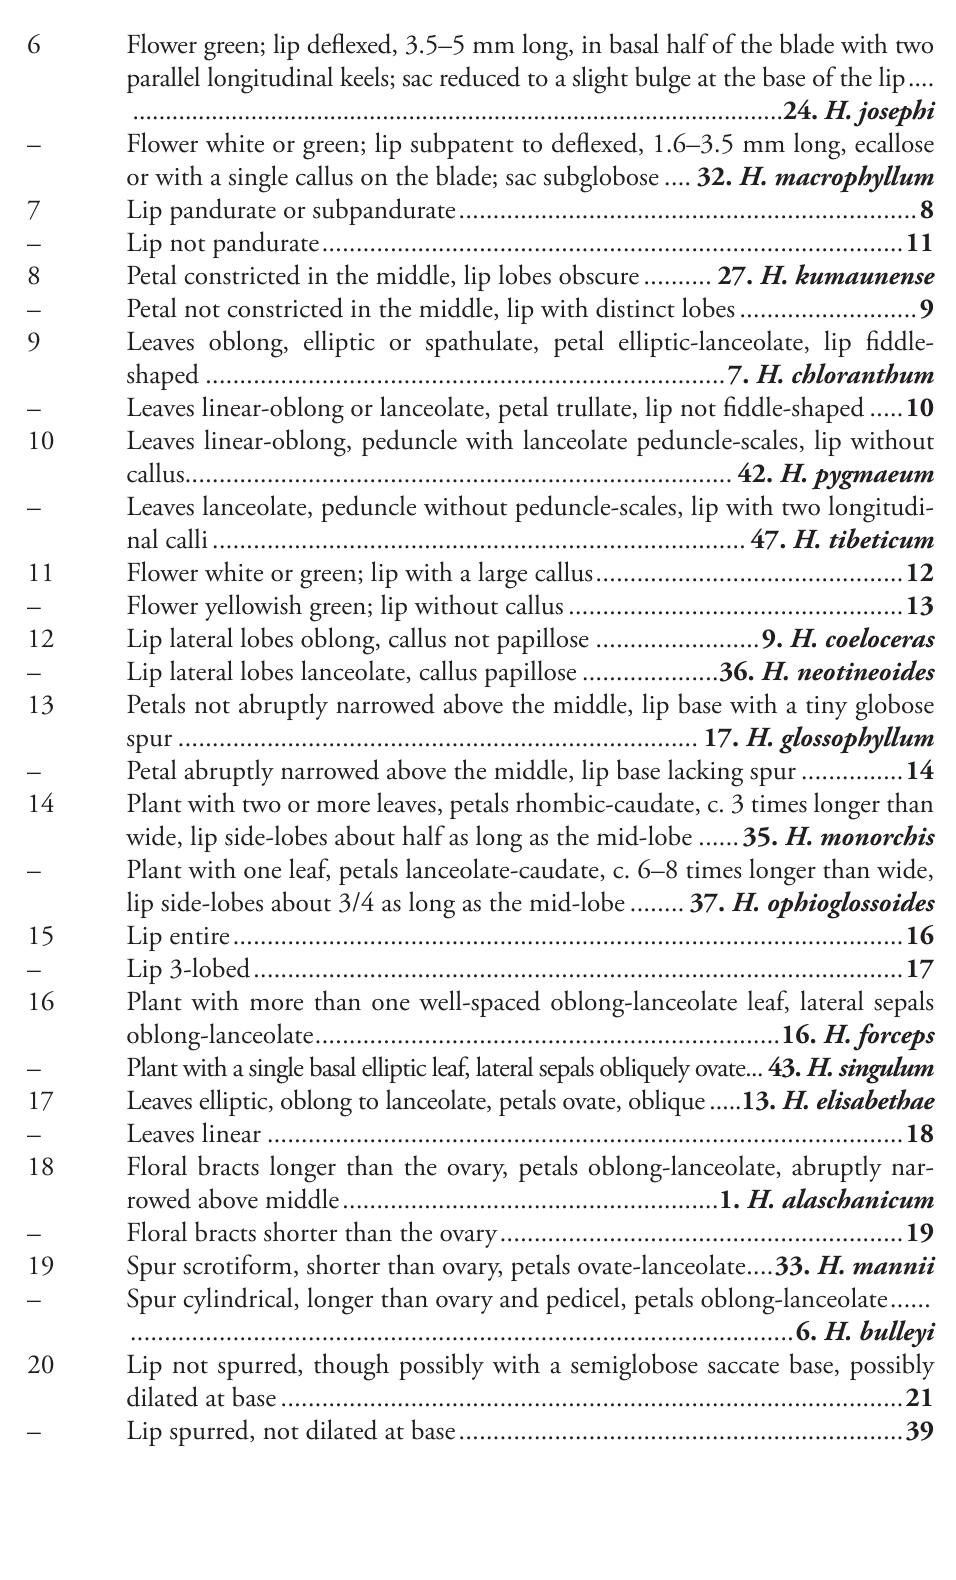
Flower green; lip deflexed, 3.5–5 mm long, in basal half of the blade with two parallel longitudinal keels; sac reduced to a slight bulge at the base of the lip